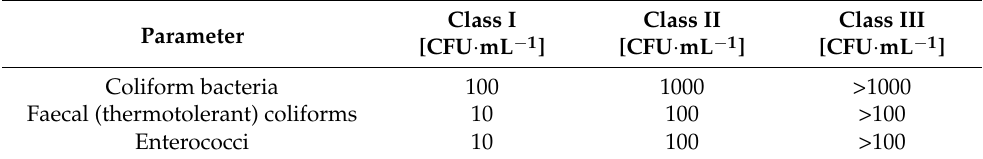
Table 7. Limits for Pathogen content in irrigation water given by Czech standard